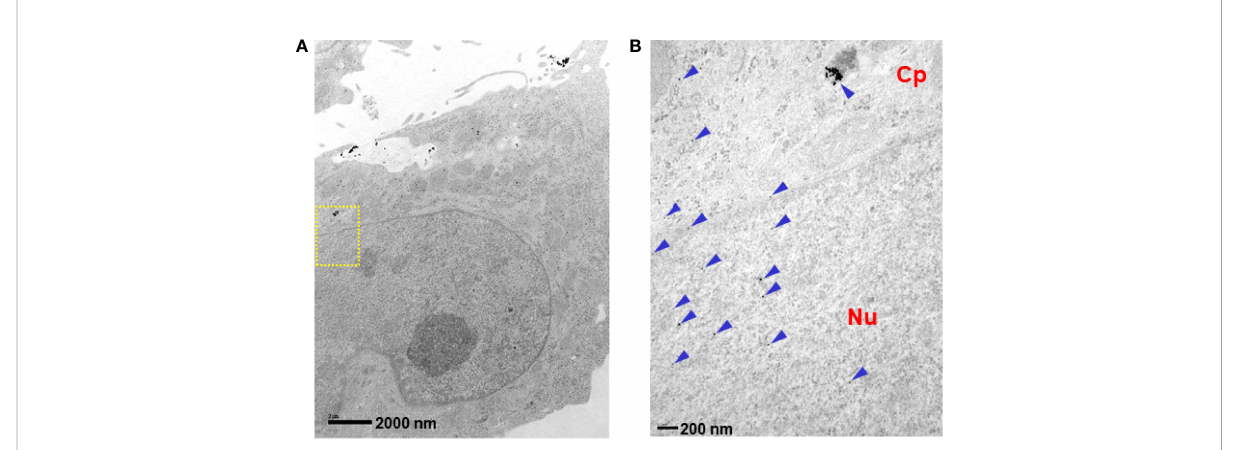
FIGURE 2 Intracellular localization of p28. LN-229 cells were treated with p28-GNRs for 2 hr. Sections (60 nm) of fi xed cells on 200 mesh copper grids were imaged. TEM images taken by a JEOL 1220 showed a signi fi cant amount of p28-GNP uptake (arrowheads). (A) : x10,000 magni fi cations, (B) : location of yellow squire at x40,000. Cp: cytoplasmic space. Nu: